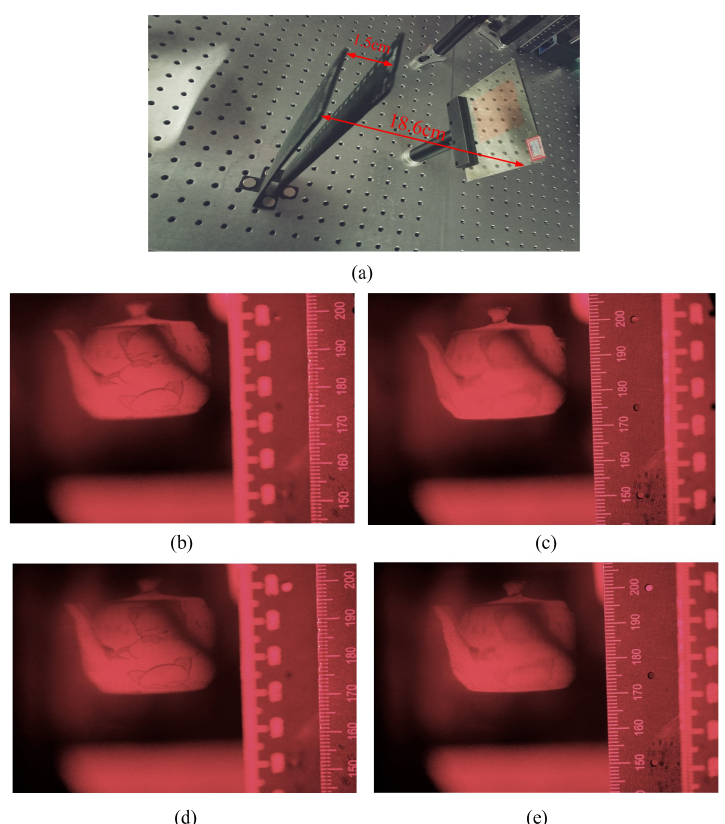
Figure 13. Comparison of reconstructed images between the EPISM method and the holographic element-based EPISM method. ( b , c ) are the reconstructed images of the EPISM method, ( d , e ) are the reconstruction images of the holographic element-based EPISM method. ( a ) The spatial position relation of two rulers and the holographic plate. ( b ) The reconstruction image of the EPISM method when focused on the farther ruler. ( c ) The reconstruction image of the EPISM method when focused on the closer ruler. ( d ) The reconstruction image of the holographic element-based EPISM method when focused on the farther ruler. ( e ) The reconstruction image of the holographic element-based EPISM method when focused on the closer ruler.